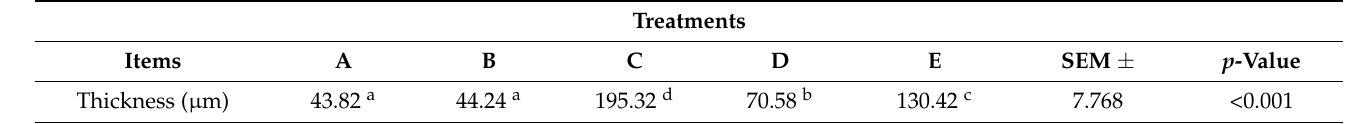
Table 5. GA decreased MG-induced mean tracheal mucosal thickness in the broilers. Treatments